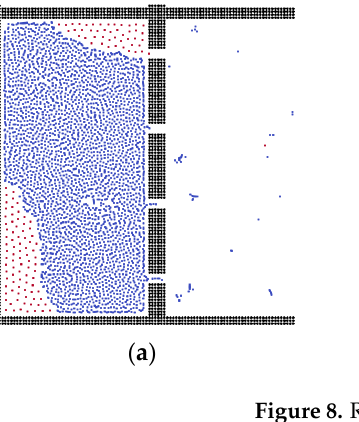
Figure 8. Results of separation with different oil viscosities: ( a ) 0.2 mPa·s; ( b ) 0.4 mPa·s; ( c ) 0.8 mPa·s.